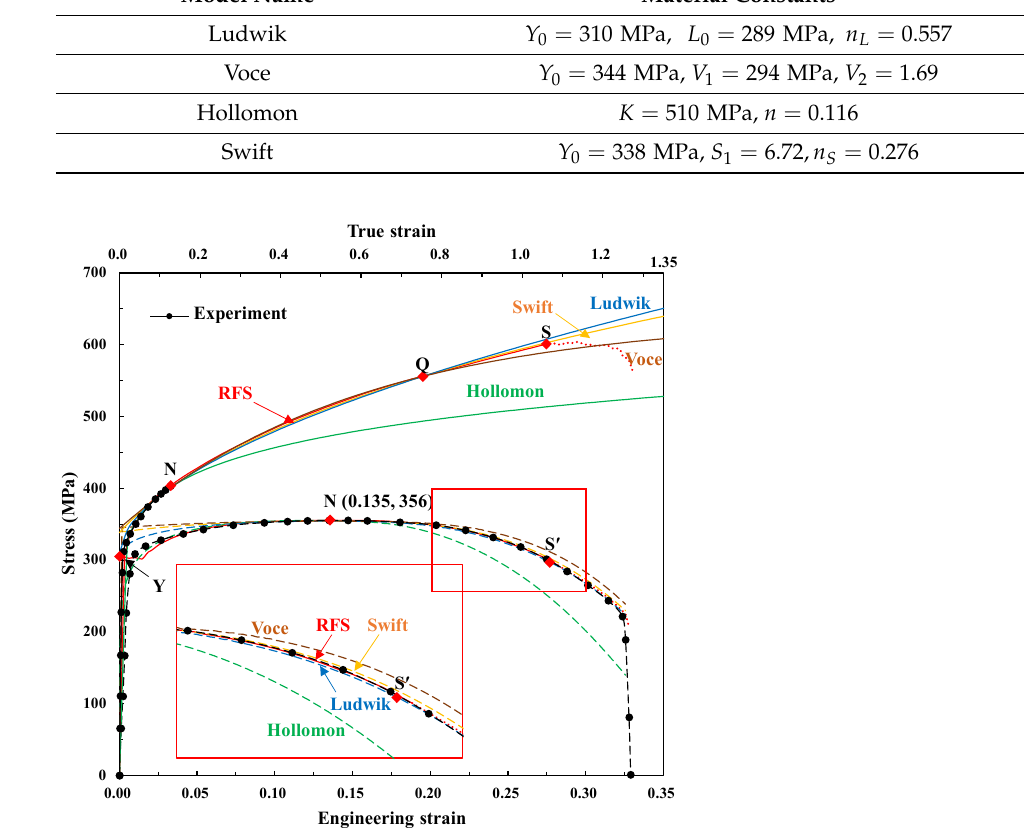
Figure 16. Comparison of flow stresses and their corresponding tensile test predictions of the four fundamental flow models with an emphasis on necking point and a selected point on the RFS curve. Table 3. Material constants of the four fundamental flow models focused on post-necking.